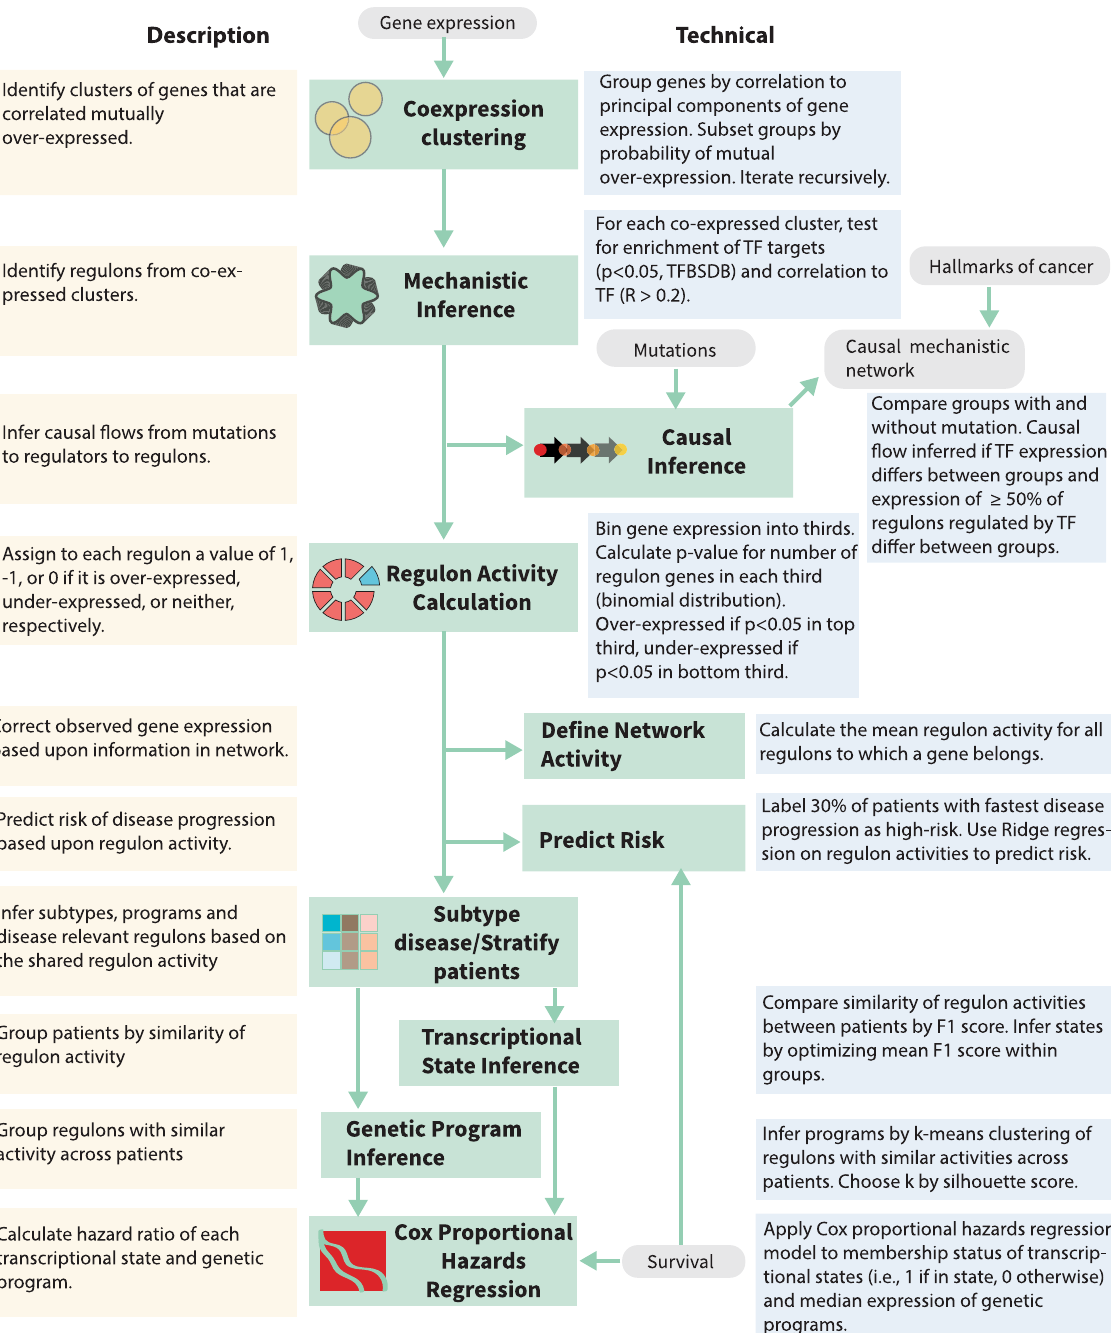
Fig. 1 Mechanistic inference of node-edge relationships (MINER). MINER applies a gene expression clustering algorithm and gold-standard gene interaction databases to infer sets of co-regulated genes called regulons. Each regulon has an associated regulator and edge direction (i.e., activation or repression), as well as an activity in each sample (e.g., overexpressed, underexpressed, etc.). When the coordinated activity of regulons changes in the context of a mutation, a causal relationship is inferred through the associated regulator. A causal and mechanistic transcriptional regulatory network is generated by evaluating the in fl uence of all potential causes (e.g., mutations, translocations, copy- number abnormalities, etc.) on all regulons. Prediction of phenotypes such as responsiveness to therapy or risk of disease progression is achieved by training machine-learning algorithms on regulon activities. The predictive signatures are then placed into a meaningful biological context by identifying their associated mechanisms and putative causes within the rank-sum test) in regulons discovered by MINER ( R = 0.84 ± 0.06) versus SCENIC ( R = 0.36 ± 0.09).